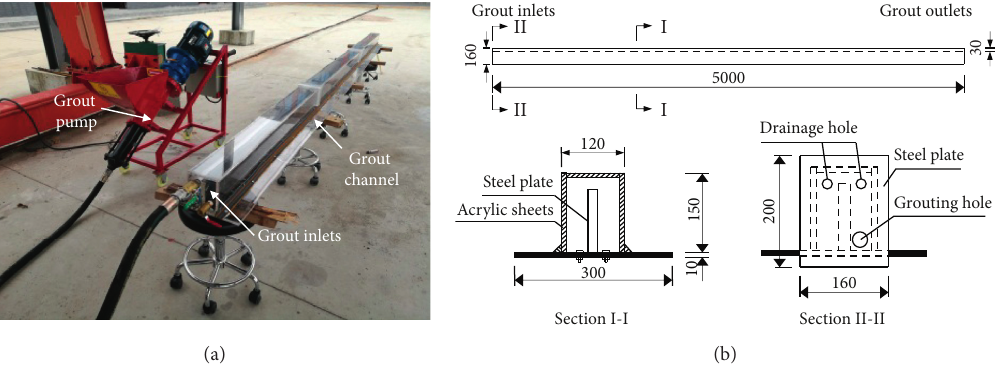
Figure 5: Test setup for pressure grouting from the channel end (dimensions in mm).